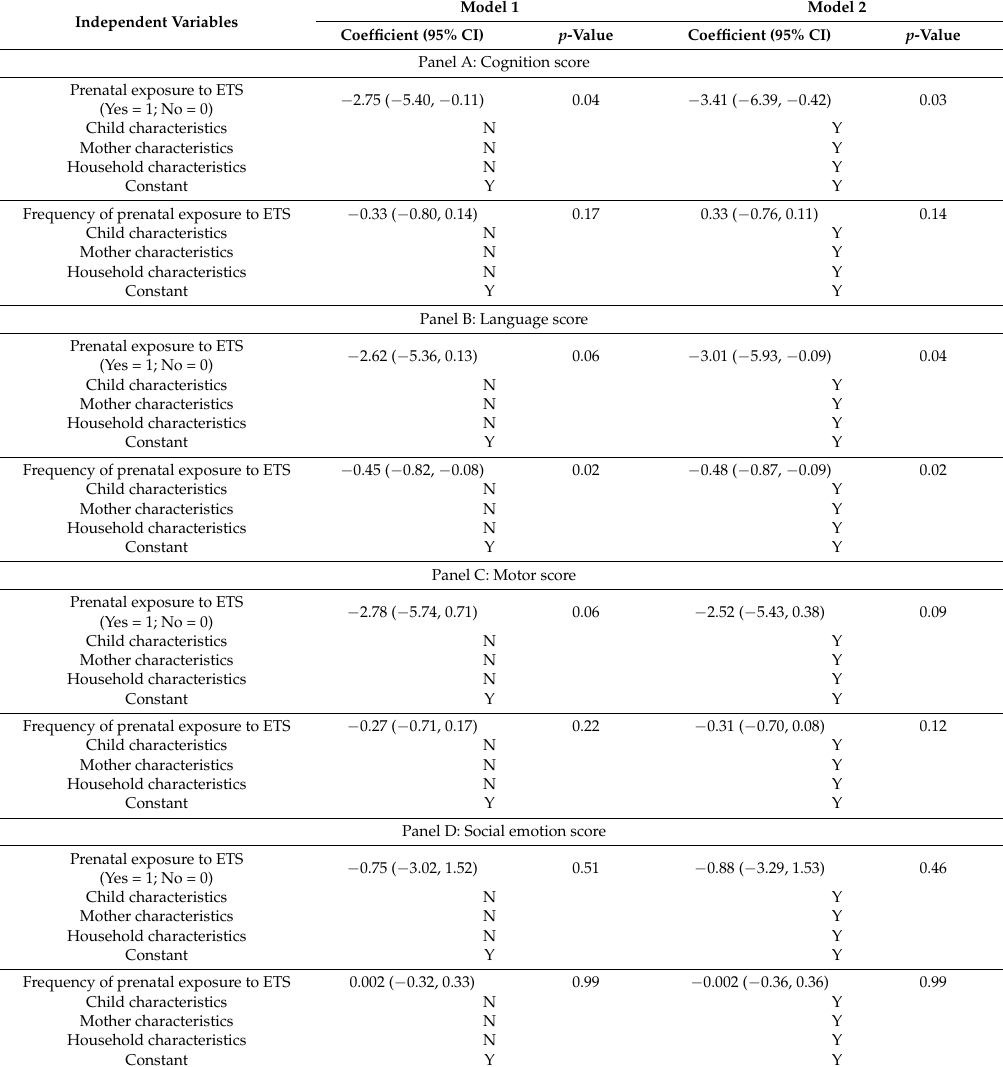
Table A2. Results of unadjusted and adjusted regressions on early development of children in rural Guizhou